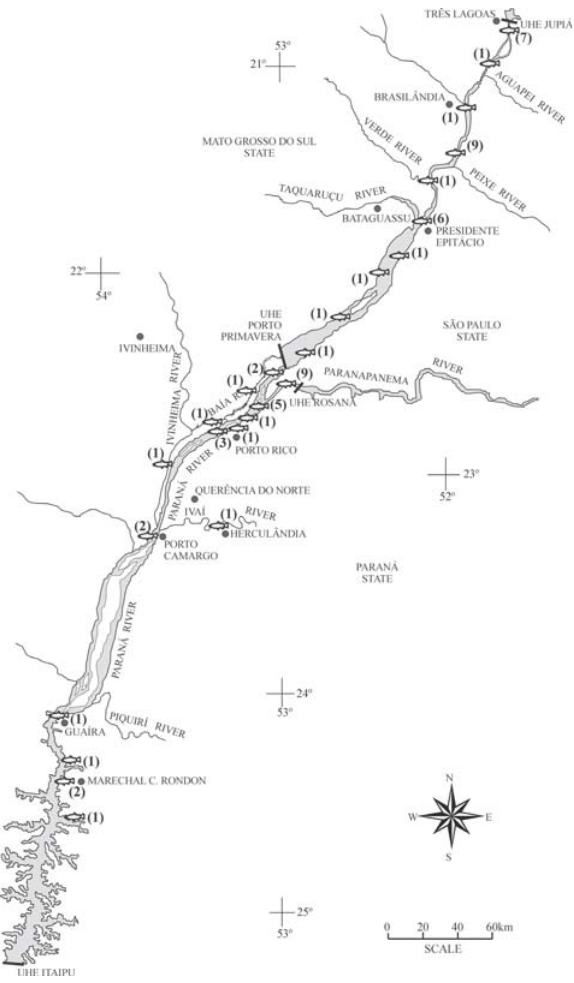
Fig. 1. Map of the study area, which includes the stretch of the Paraná River between the Jupiá and Itaipu reservoirs. Numbers between parentheses are the numbers of individu- als of curimba ( Prochilodus lineatus ) recaptured in each place (details given in Table 3. Number of individuals recaptured downstream from the Porto Primavera Dam. n = number of specimens; PR = Paraná River; PRP = Paranapanema River; IVI = Ivinheima River; BAI = Baia River; IVA = Ivaí River. The combinations Down-Down and Up-Down indicate the release and recapture localities respectively.